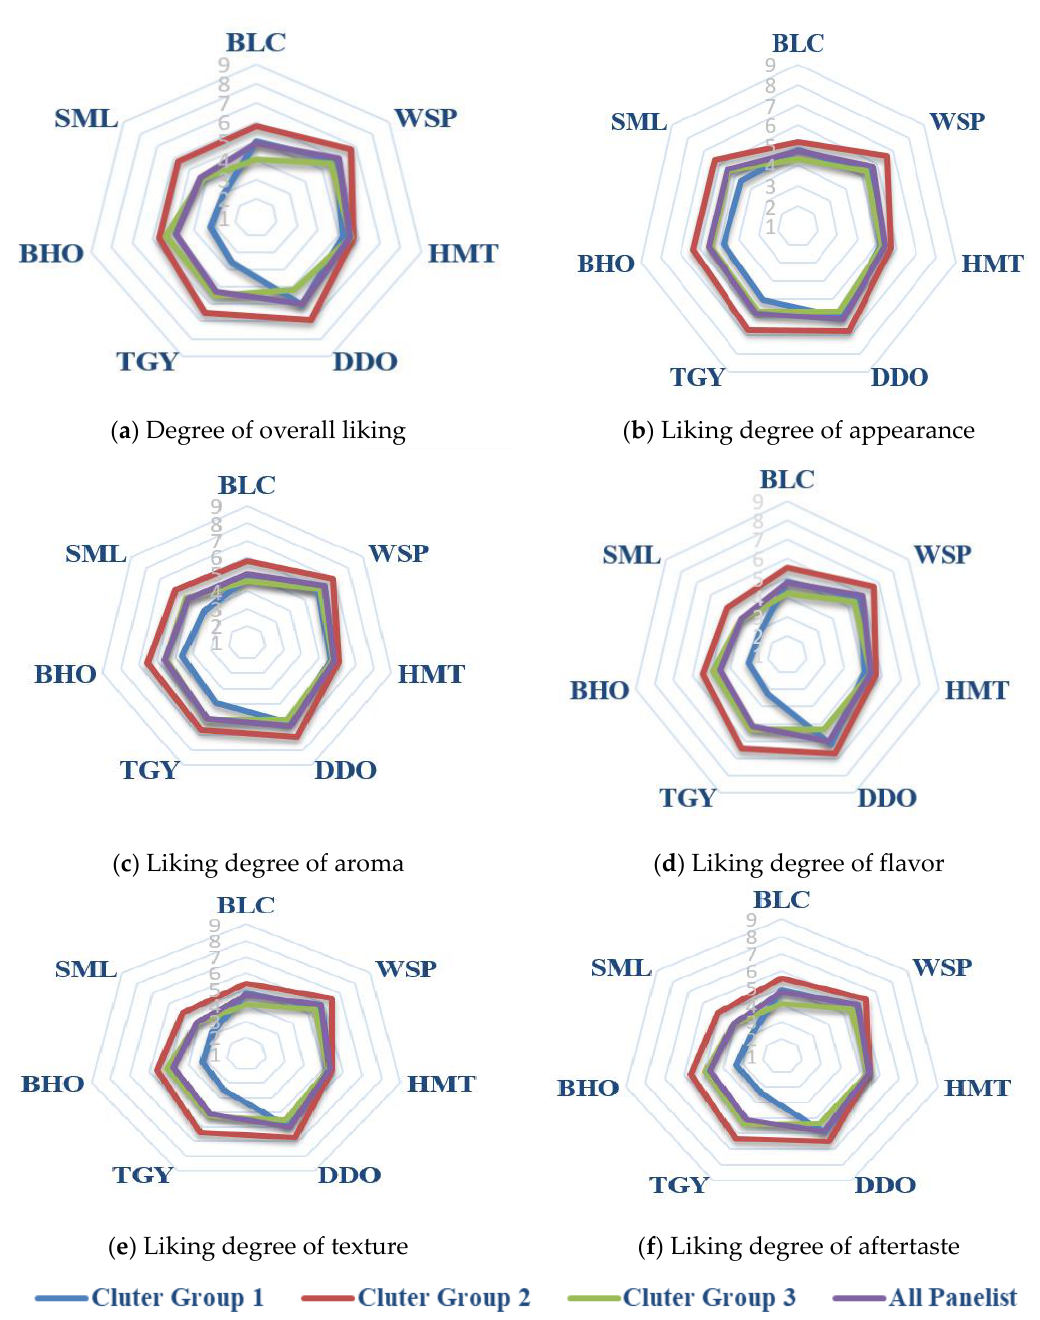
Figure 3. Preference degrees for the seven cold tea infusions revealed by a 9-point hedonic test in view of overall liking and individual sensory qualities. ( a ) Degree of overall liking; ( b ) Liking degree of appearance; ( c ) Liking degree of aroma; ( d ) Liking degree of flavor; ( e ) Liking degree of texture; ( f ) Liking degree of aftertaste.